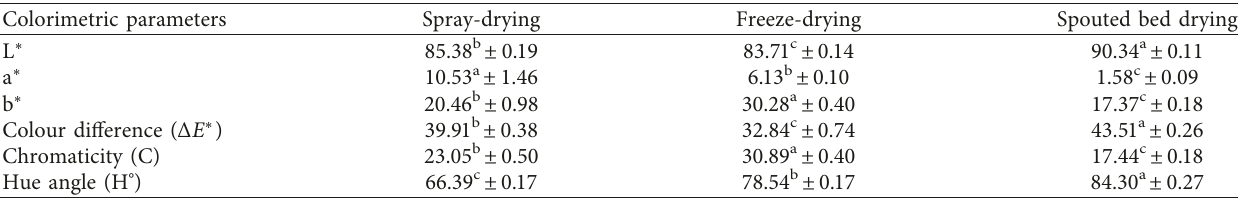
Table 3: Colorimetric parameters of acerola-ceriguela (60% acerola and 40% ceriguela) mixed powder pulps obtained by the different drying